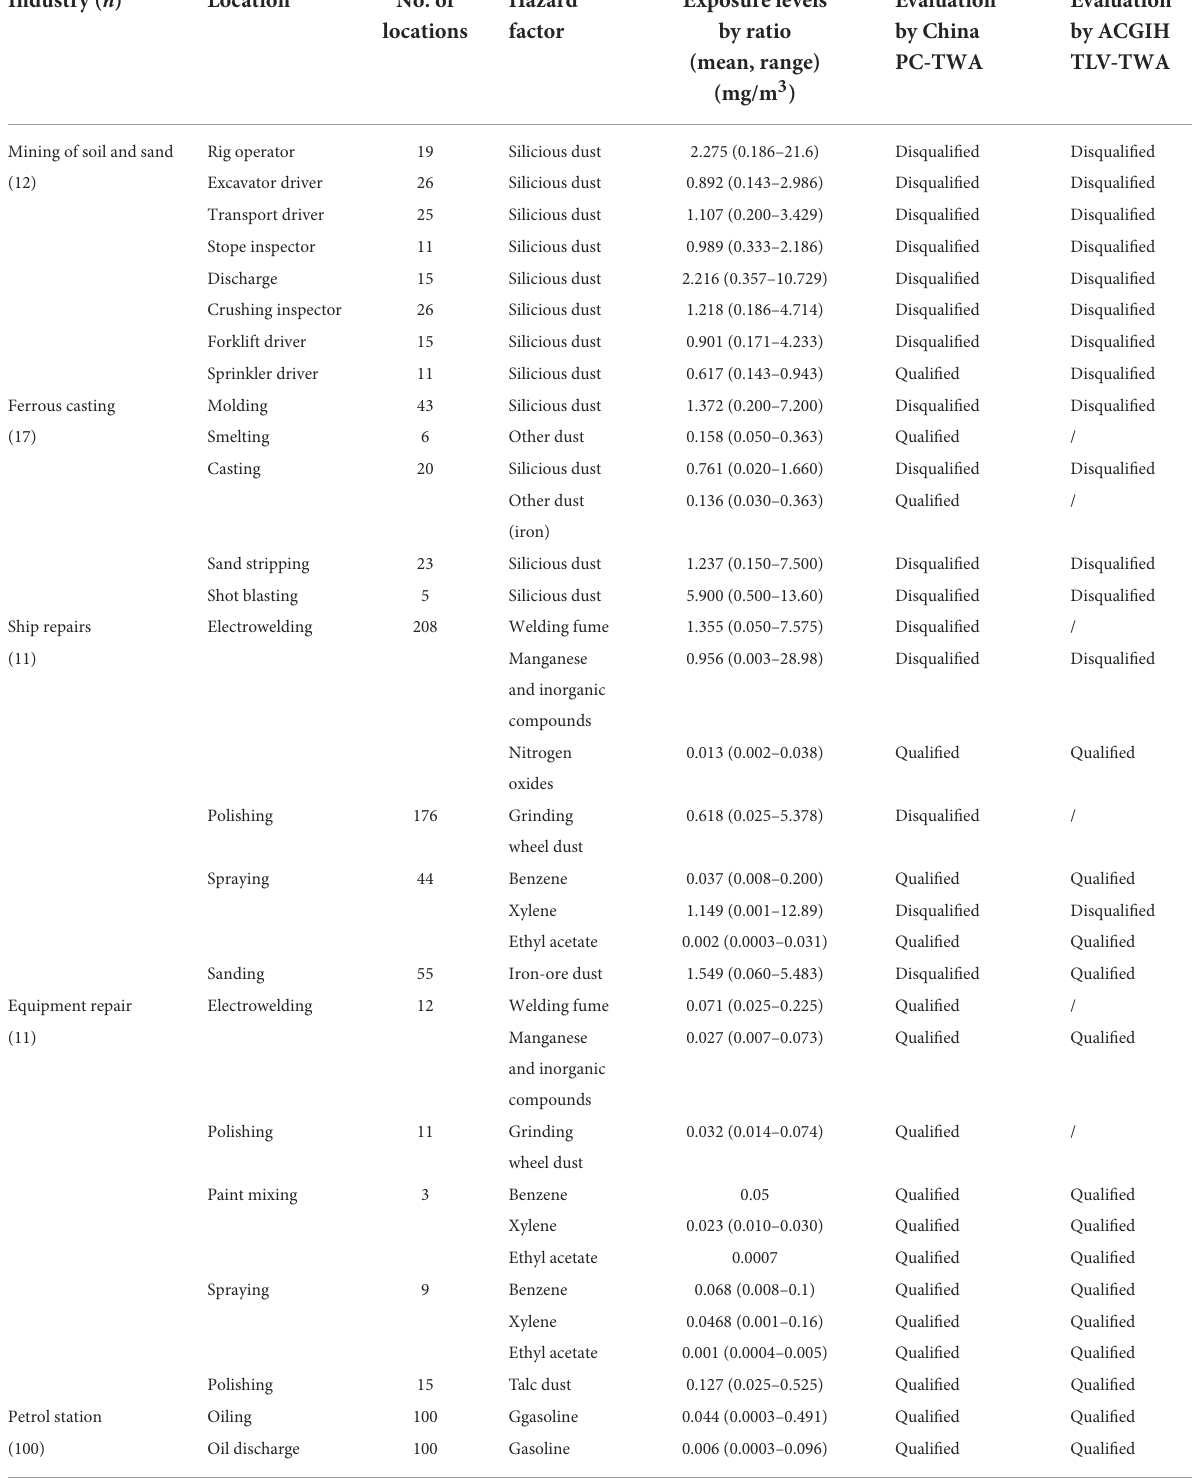
TABLE 1 General information and exposure levels of hazard factors in five typical